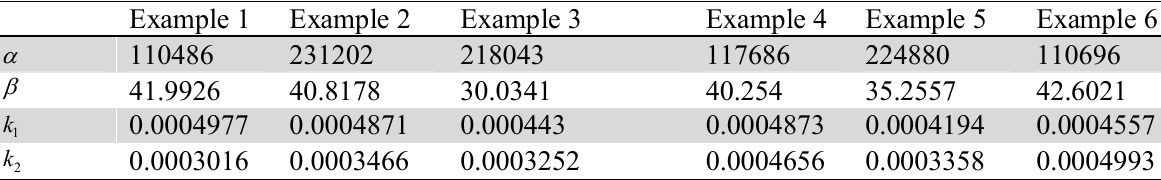
The ranges of parameters